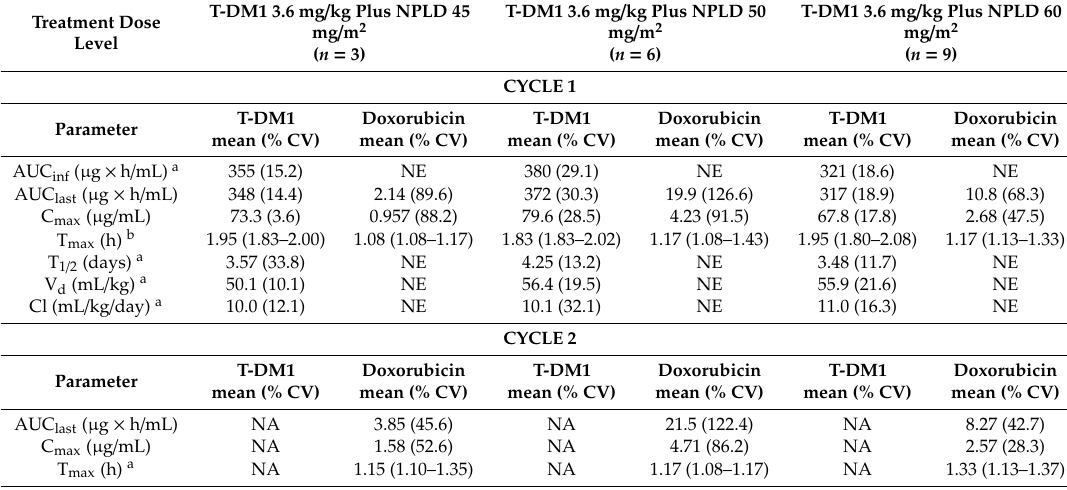
Table 4. Pharmacokinetic parameters of trastuzumab emtansine (T-DM1) and doxorubicin by treatment dose